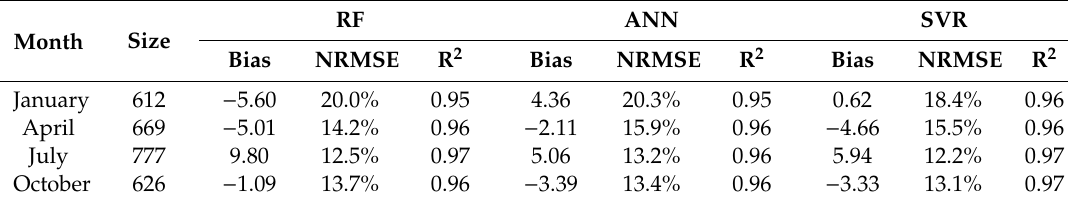
Table 4. Error statistics of NSSR retrieval using machine learning algorithms in typical